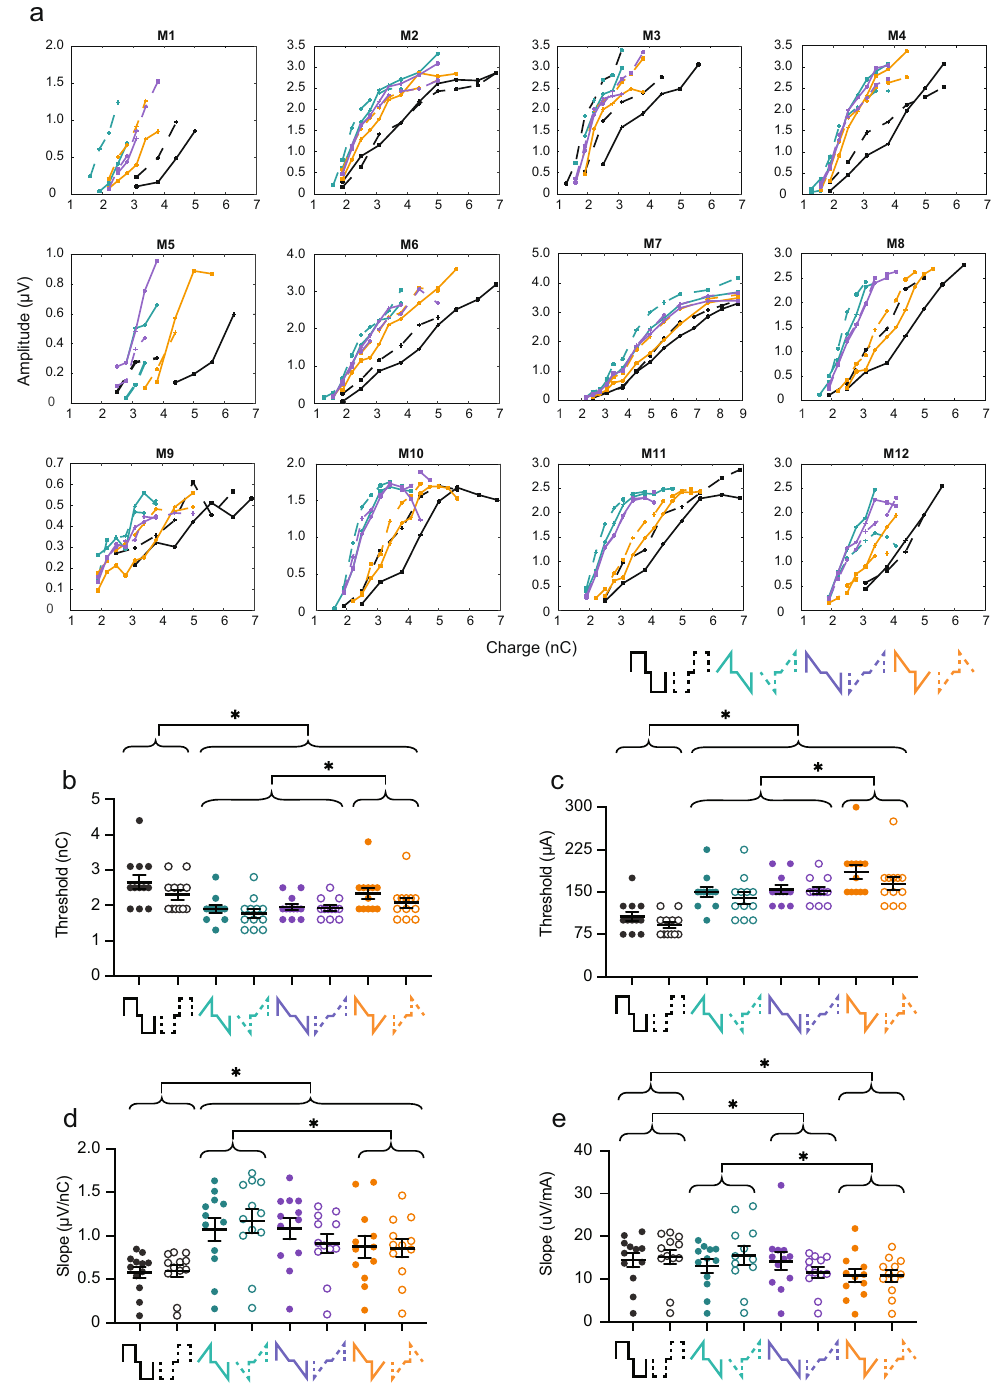
Figure 2. Ramped pulse shapes produce a lower threshold and steeper growth function of eABR wave II compared to rectangular shapes in terms of injected charge. ( a ) Individual amplitude growth functions of wave II as a function of charge injected (Mouse (M)1–12). Pulse shapes are indicated by color and shown in the legend (bottom right). Solid line, anodic-first; dashed, cathodic-first. ( b ) Thresholds of wave II in charge. Pulse shapes are shown below the x-axis. Each circle is data from one mouse. Closed circles, anodic-first pulses; open circles, cathodic-first pulses. ( c ) Thresholds of wave II in amplitude current level. ( d ) Slopes of the growth function of wave II in charge ( μ V/nC). ( e ) Slopes of the growth function of wave II in amplitude current level ( μ V/ μ A). Asterisks denote significant effect of the factor pulse shape in post-hoc test. * p ≤ 0.05. n = 12. Error bars are